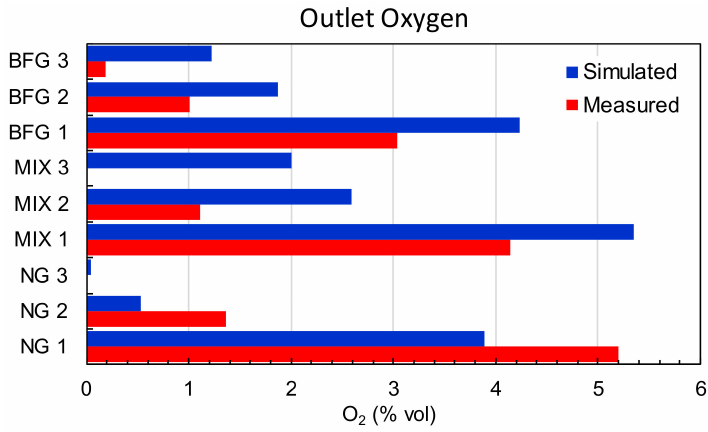
Figure 9. Comparison of oxygen concentrations measured and simulated.